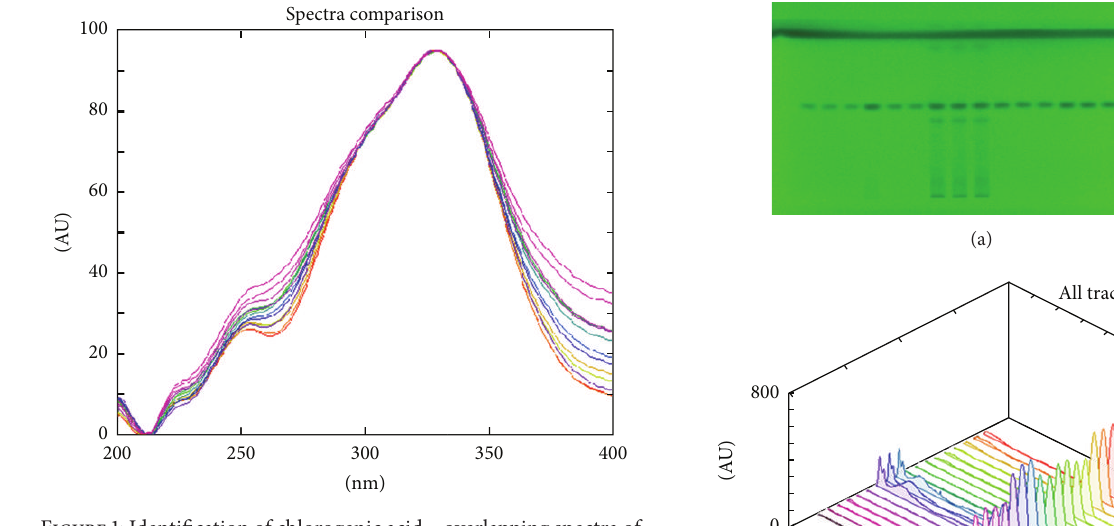
Figure 1: Identification of chlorogenic acid—overlapping spectra of standards and erva samples.